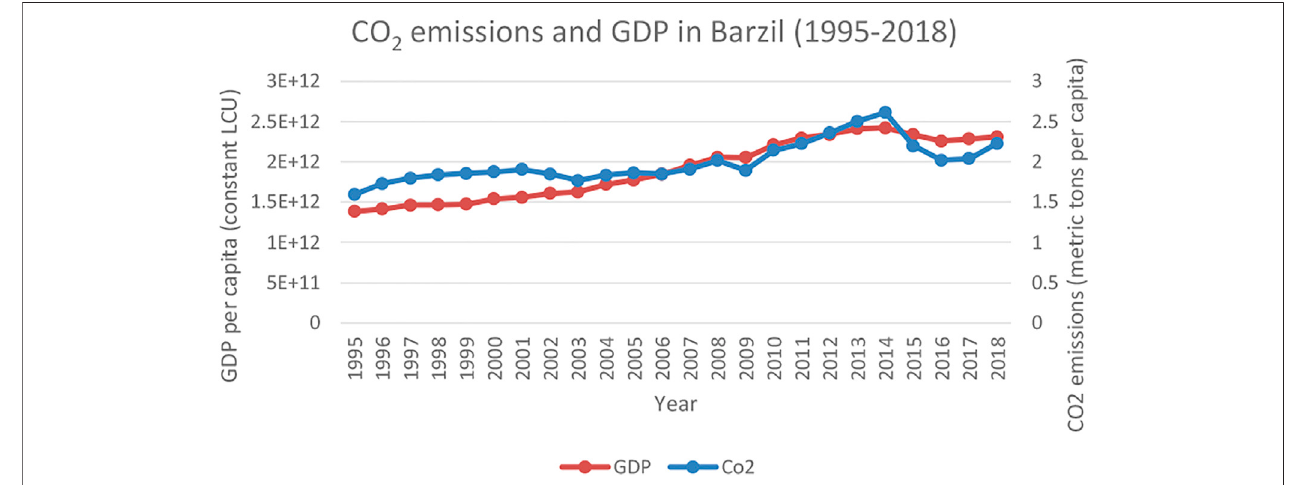
FIGURE 1 | CO 2 emissions and GDP. Source: World Development